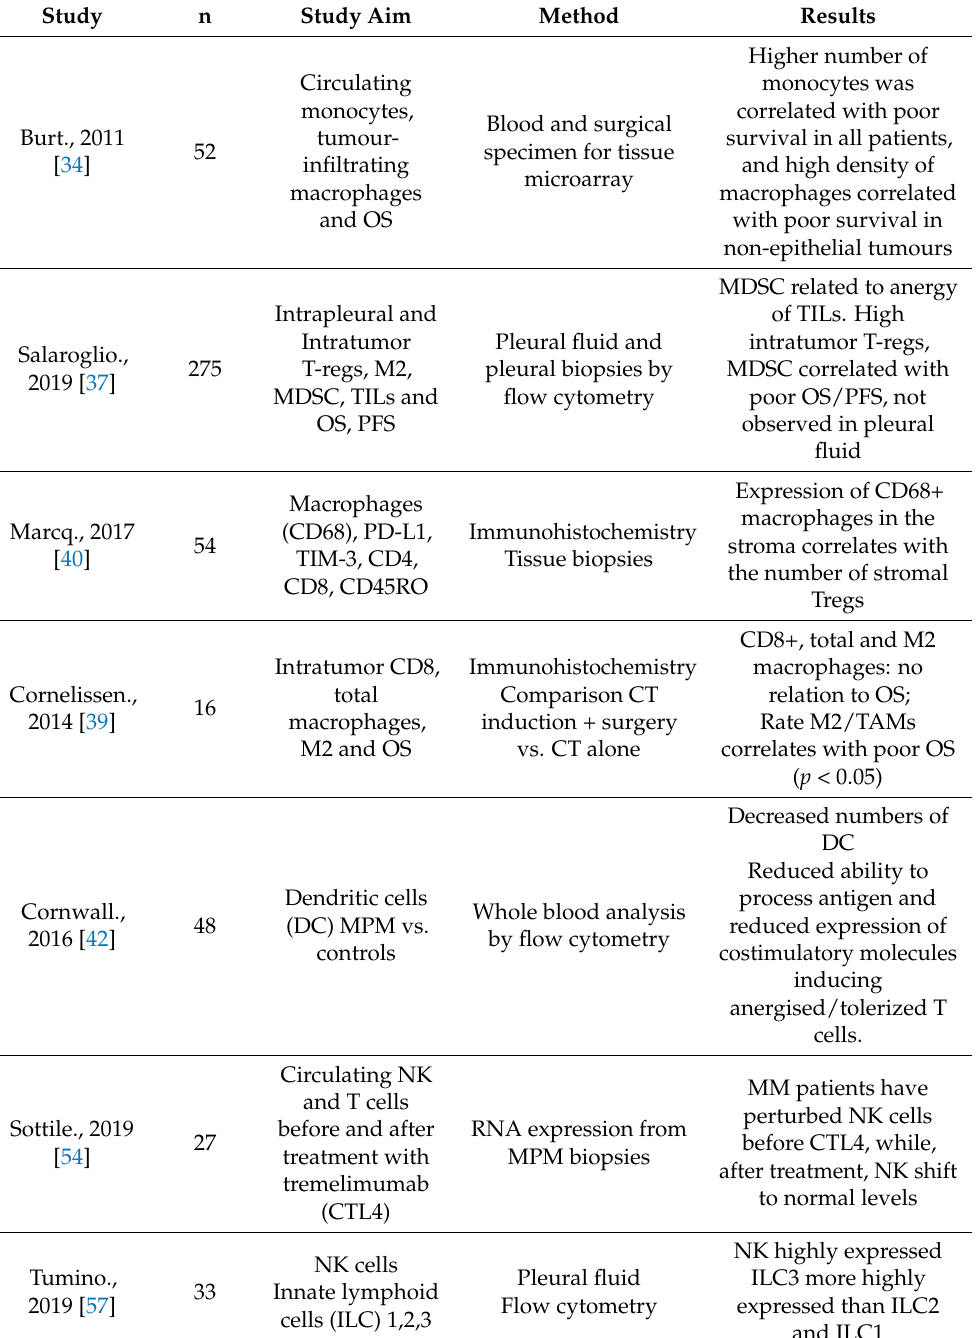
Table 1. Studies assessing the innate immune cells microenvironment of